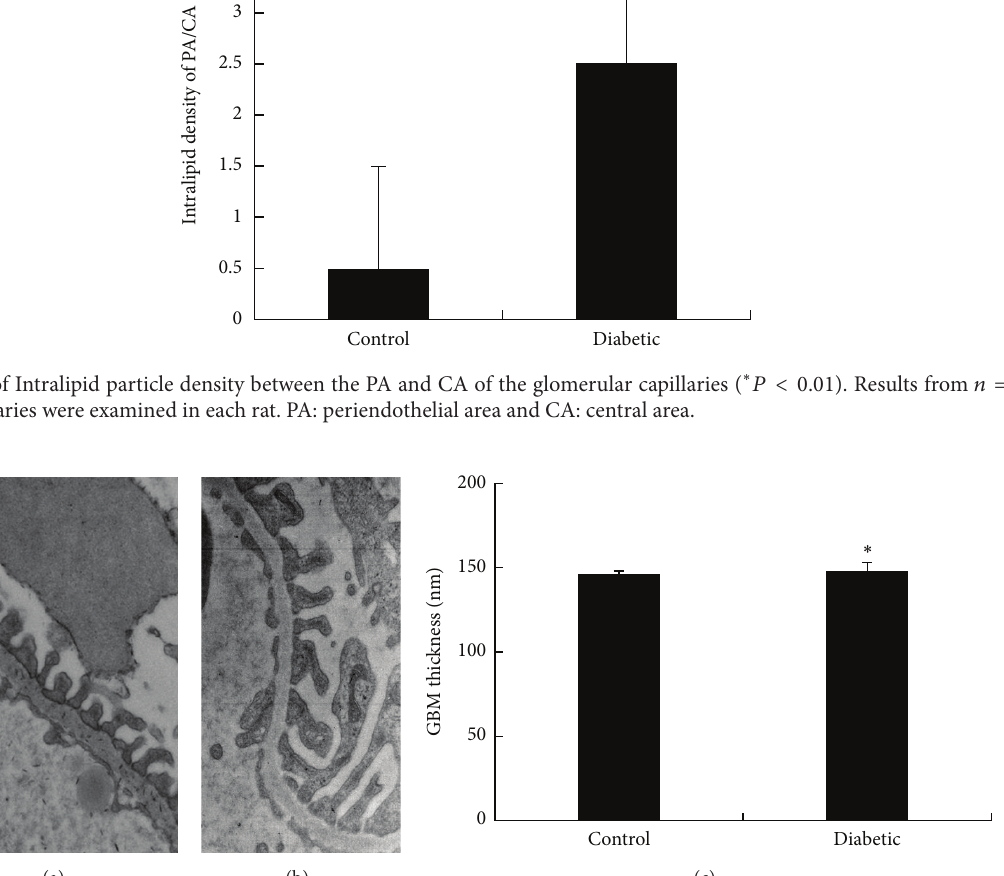
Excessive generation of reactive oxygen species (ROS) is central to the pathogenesis of diabetic nephropathy